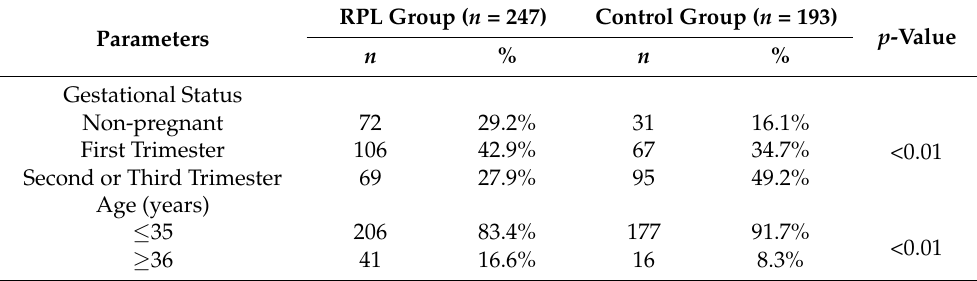
Table 1. The Sociodemographic and clinical information of the RPL group and the control group.